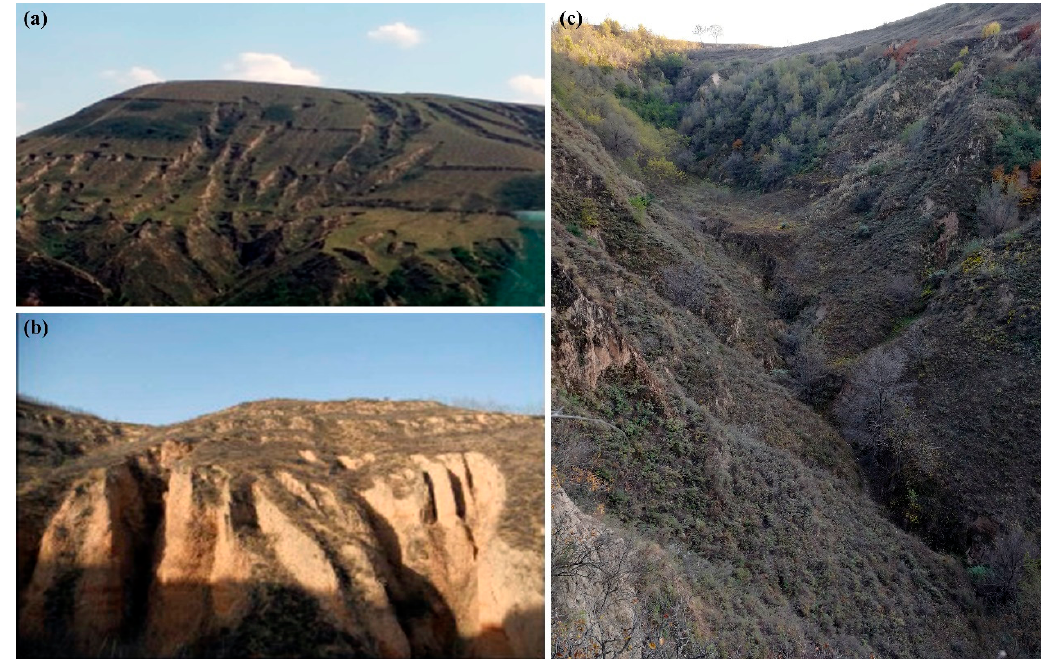
Figure 2. Three main gully types in the Loess Plateau region. ( a ) Hillslope gully, photo by author; ( b ) valley bank gully, photo from Li, et al. [1]; ( c ) valley floor gully, photo by author.